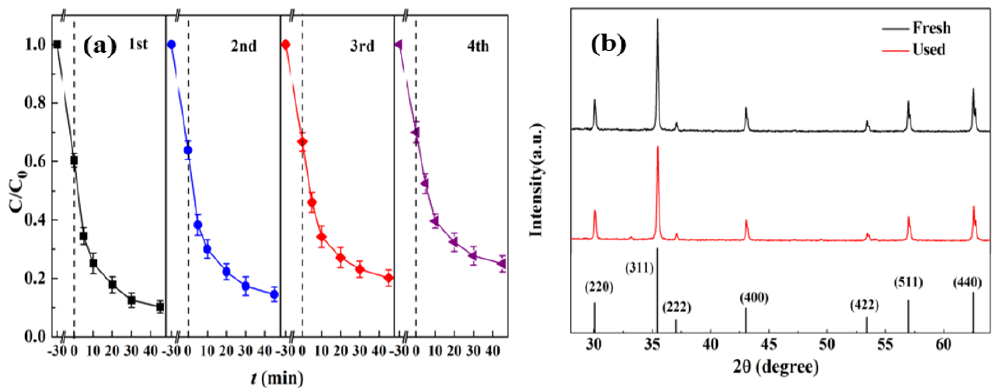
Figure 2. Recycling experiment of rGO-Fe 3 O 4 ( a ) and XRD patterns of the fresh and used rGO-Fe 3 O 4 ( b ) [33].